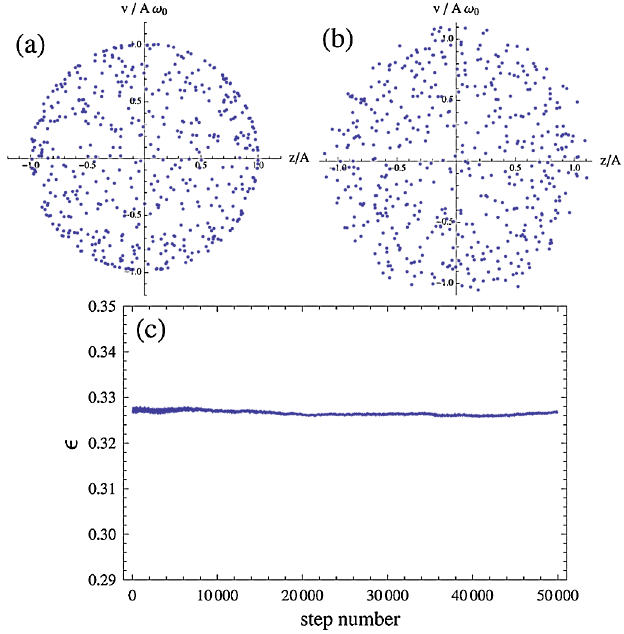
FIG. 6. (Color) Simulation result of a 1D nonrotating galaxy model: (a) Initial phase space distribution of 500 stars; (b) final distribution after 2000 = 2 (cid:2) periods; (c) plot of galaxy emittance p ffiffiffiffiffiffiffiffiffiffiffiffiffiffiffiffiffiffiffiffiffiffiffiffiffiffiffiffiffiffiffiffiffiffiffiffiffiffiffiffiffiffiffiffiffiffiffiffiffi A Þ 2 þ ð z=A Þ 2 (cid:4) = 2 (cid:5) ¼ ½ð v=! as a function of the step number 0 t= (cid:1) t , showing no sign of instability.